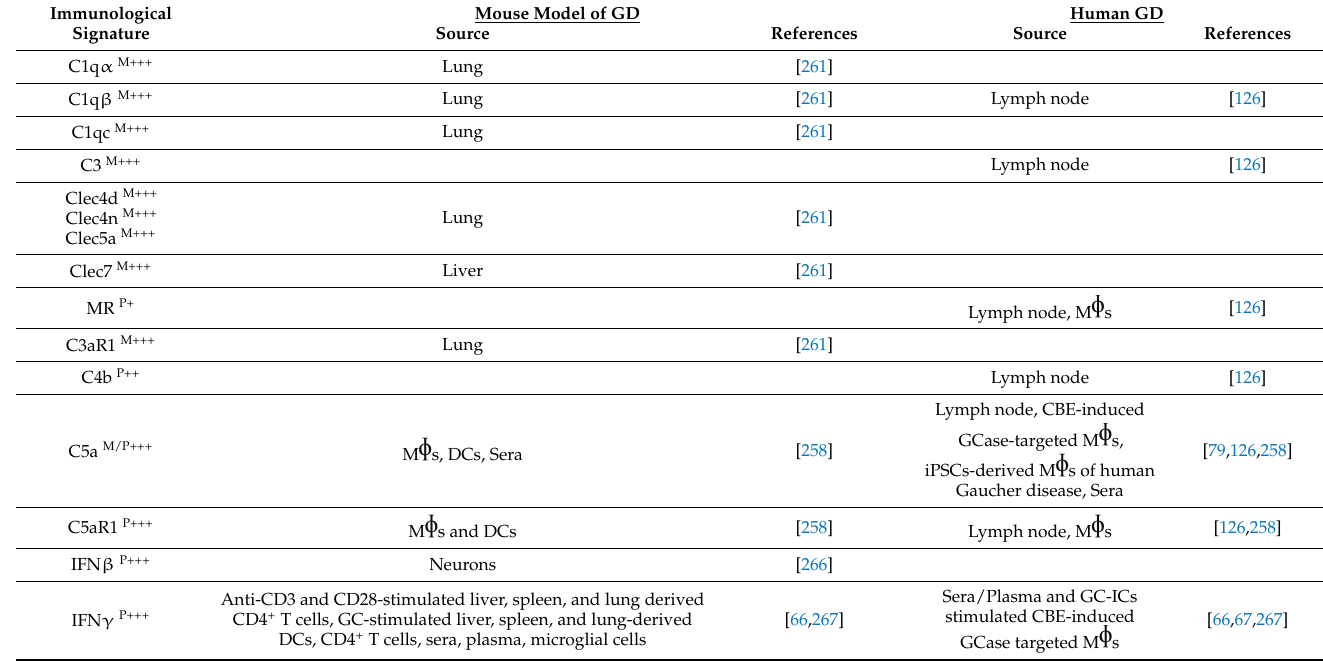
Table 4. Immune cells and their effector inflammatory mediators in